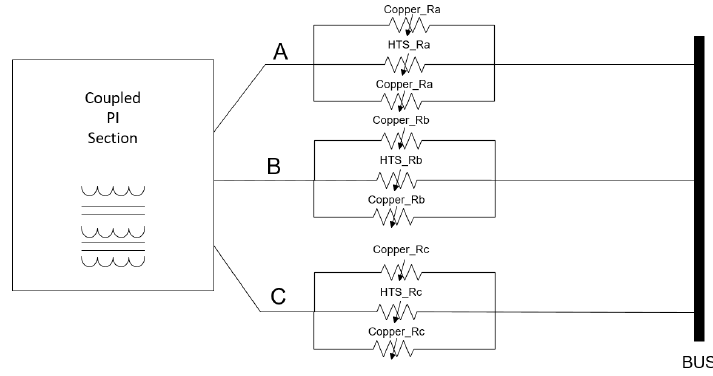
Figure 4. Equivalent electrical circuit of the modeled cable.